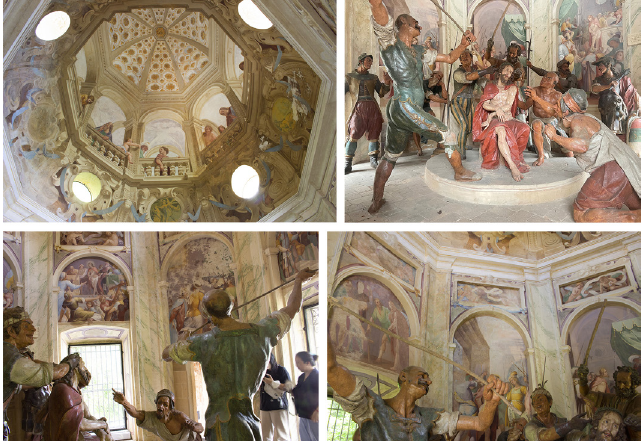
Fig. 8 Chapel VIII, frescoes and sculptural